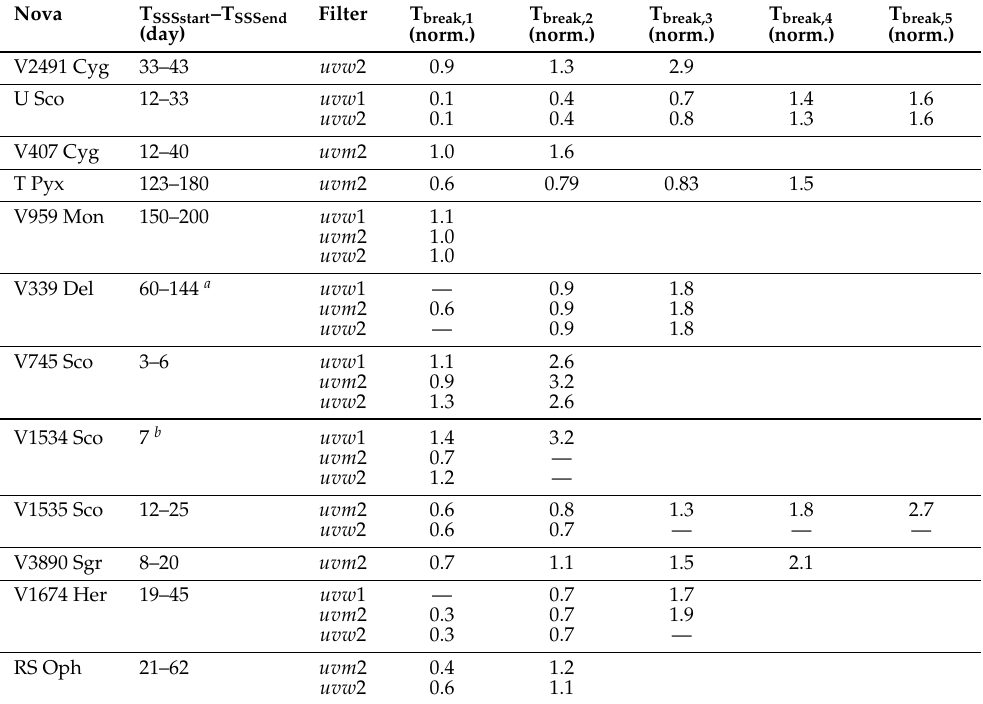
Table 3. The nth break time normalised to the end time of the X-ray SSS: T break,n (norm.) = T break,n /T SSSend . The power-law indices are the same as in Table 2, so have not been listed. Nova T SSSstart –T SSSend Filter T break,1 T break,2 T break,3 T break,5 (day) (norm.) (norm.) (norm.) (norm.)